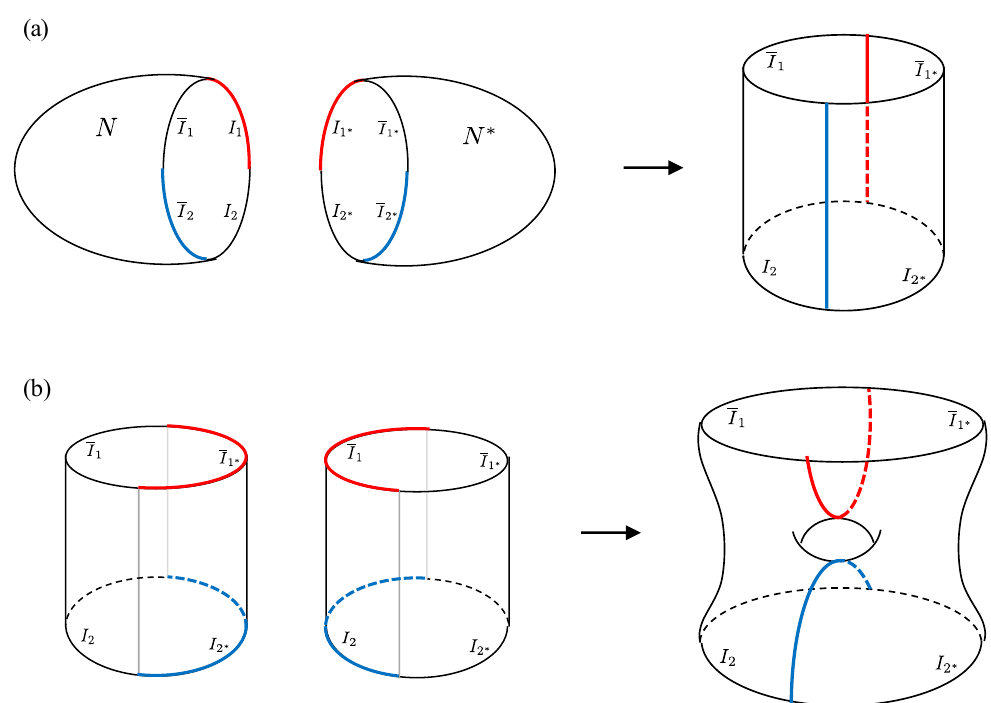
( (cid:26) T 1 ) y gives a path integral on a cylinder. (b): taking I I